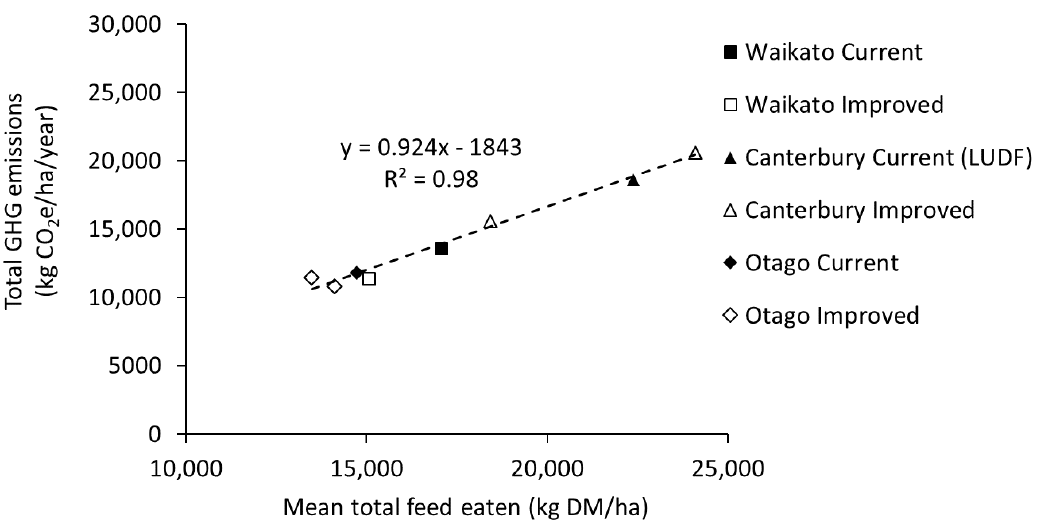
Figure 1. Relationship between mean total feed eaten (kg DM/ha) and total GHG emissions for ‘current’ and ‘improved’ systems trialled in three regions of New Zealand. Also included is the Canterbury ‘current’ system based on an updated analysis of the Lincoln University Dairy Farm (LUDF) system (P. Beukes, pers. comm.).